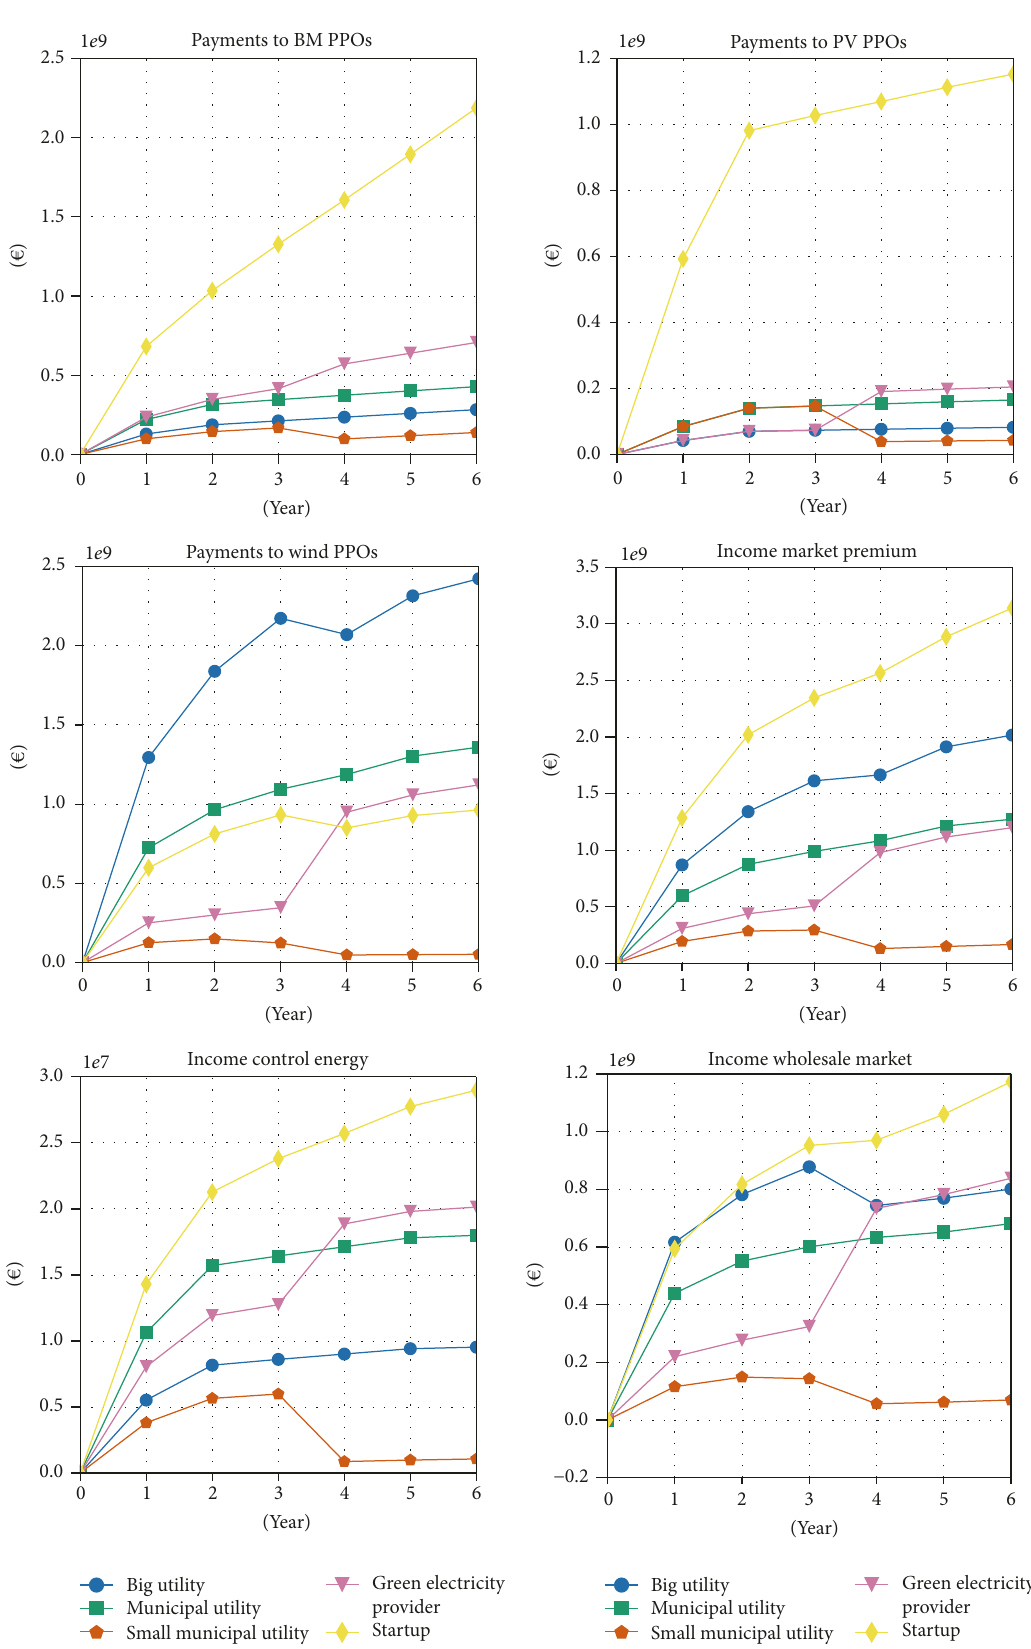
Figure 9: Scenario 1 results. Income and expenses of the